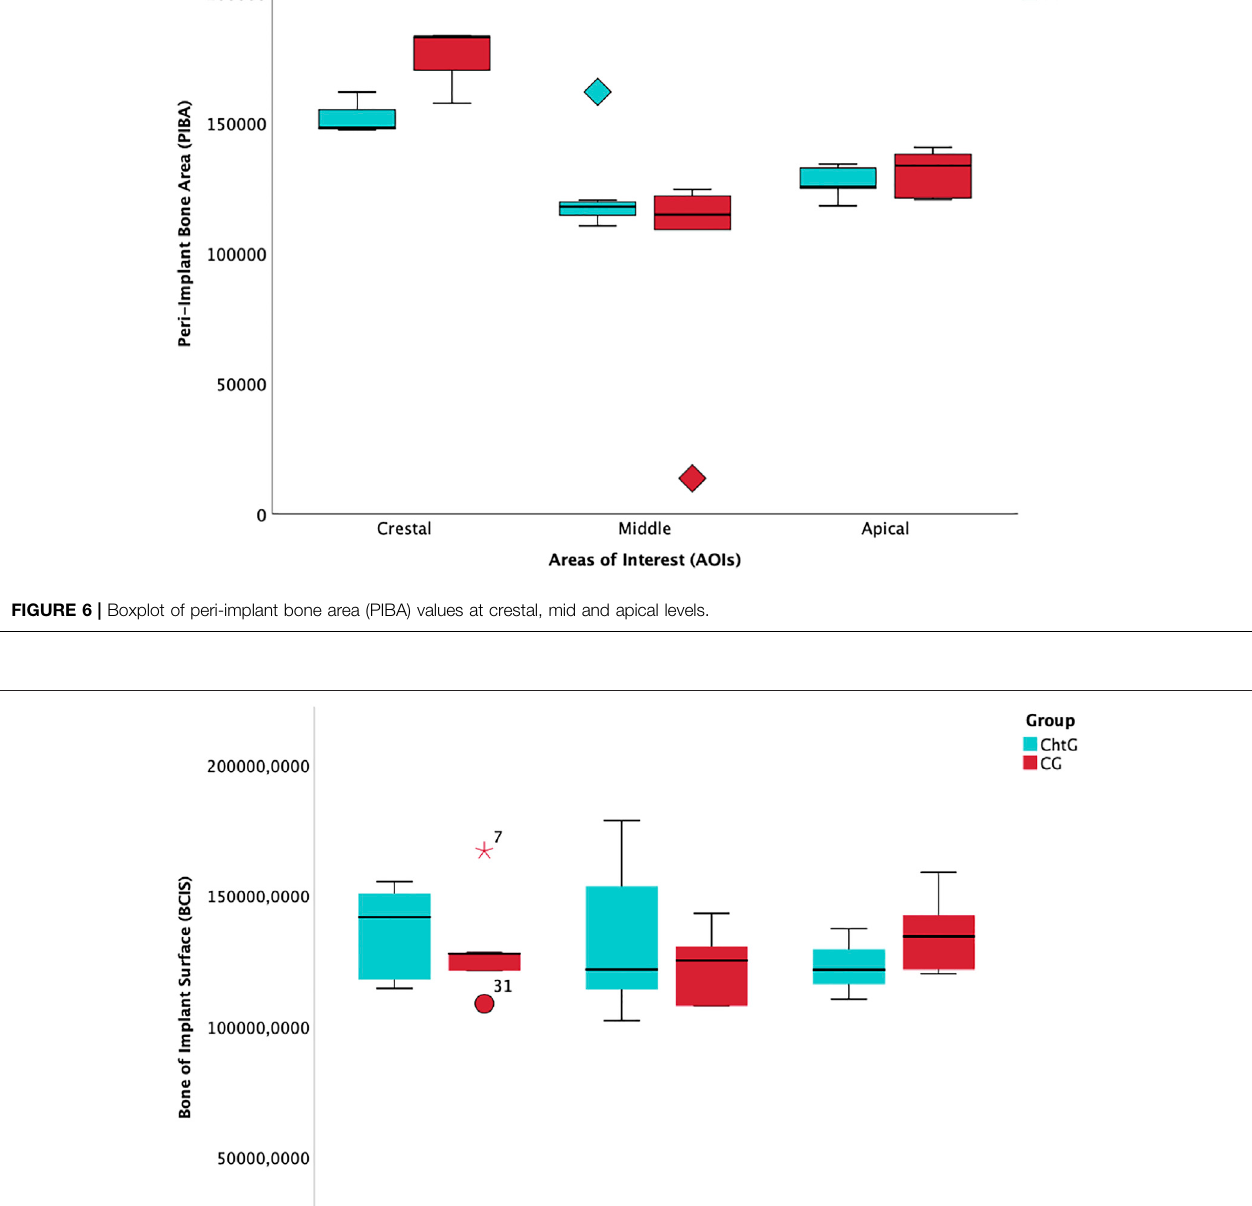
Frontiers in Bioengineering and Biotechnology |